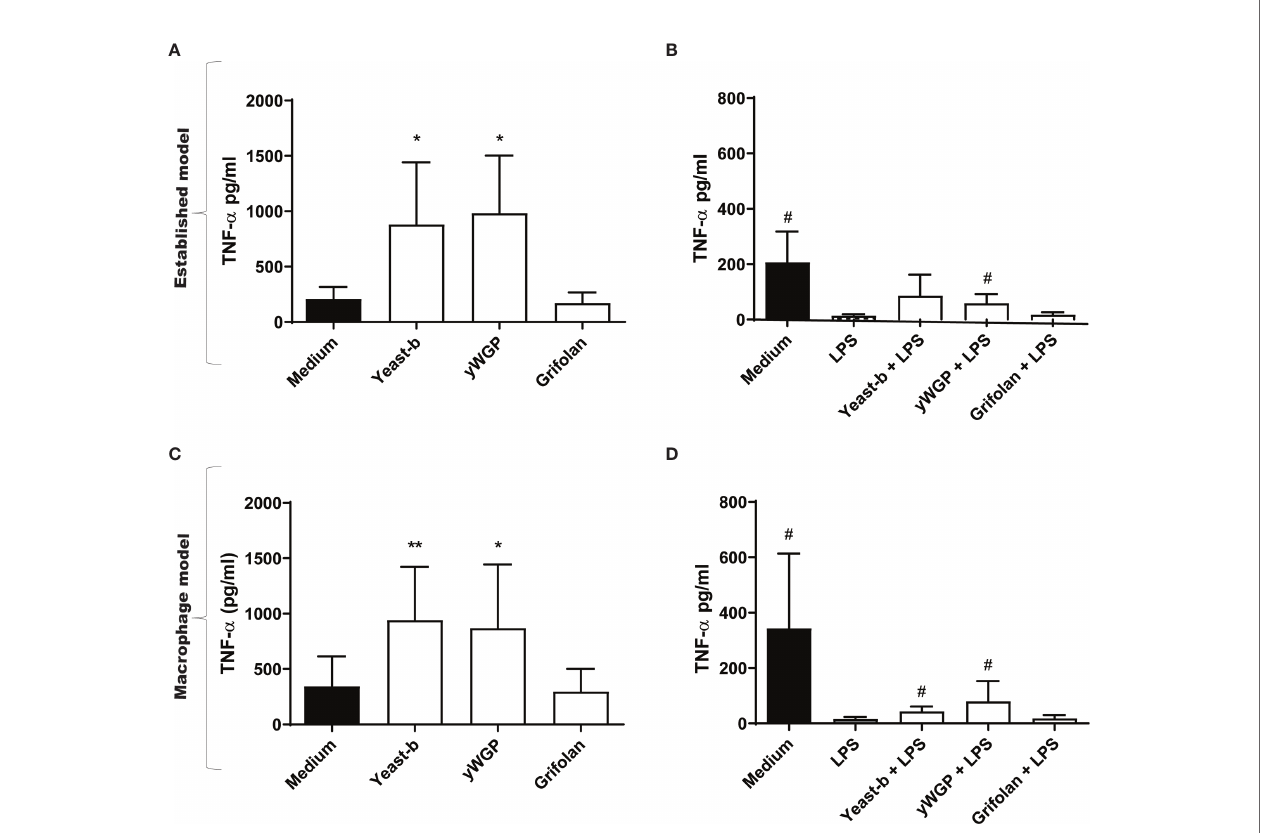
FIGURE 2 | Beta-glucans induced training and increase resilience in both trained immunity protocols. The protocols of the in vitro training and resilience model for (A – D) are schematically depicted in Figure 1 and described in the legend to Figure 1 , with the adjustment that 50 ng/ml M-CSF was added to step I-III for (C) and (D) Results from training (A) and induced resilience (B) when applying the established protocol and training (C) and induced resilience (D) when applying the controlled M-CSF-mediated macrophage differentiation protocol are shown in a bar graph as average pg/ml TNF- a ± SD of n =5 different donors. Data was analyzed with paired Student ’ s t test and statistical signi fi cances were indicated: *P < 0.05 compared to the medium control; **P < 0.01 compared to the medium control; # P < 0.05 compared to the LPS